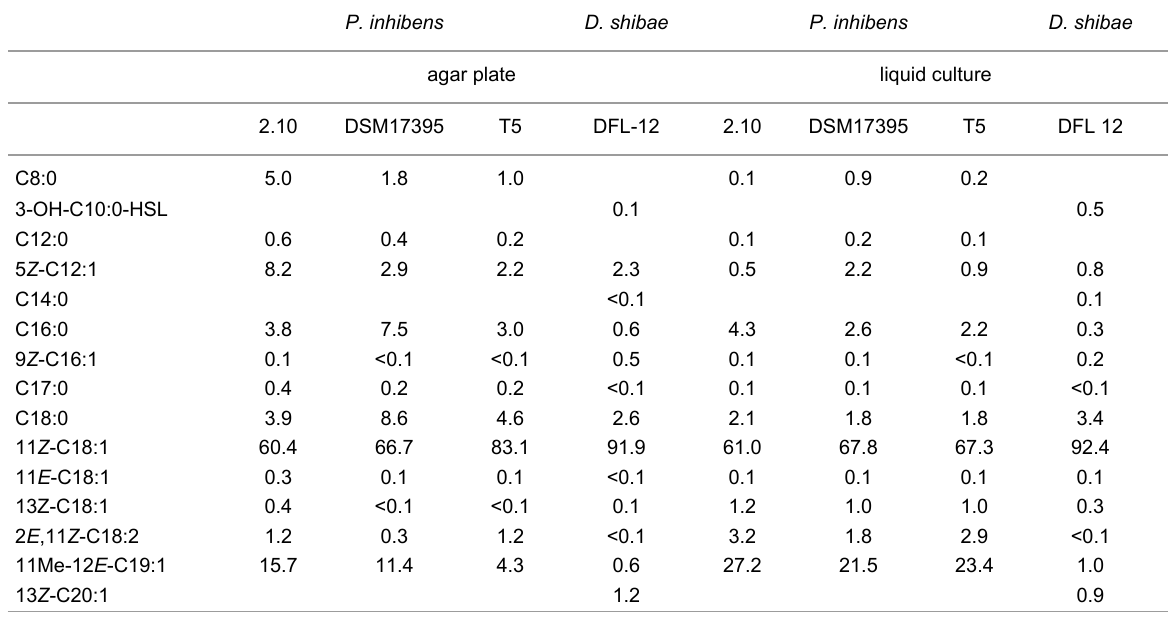
Table 2: Presence of bound or free fatty acids in four different Roseobacter group strains detected as methyl esters. a P. inhibens D.